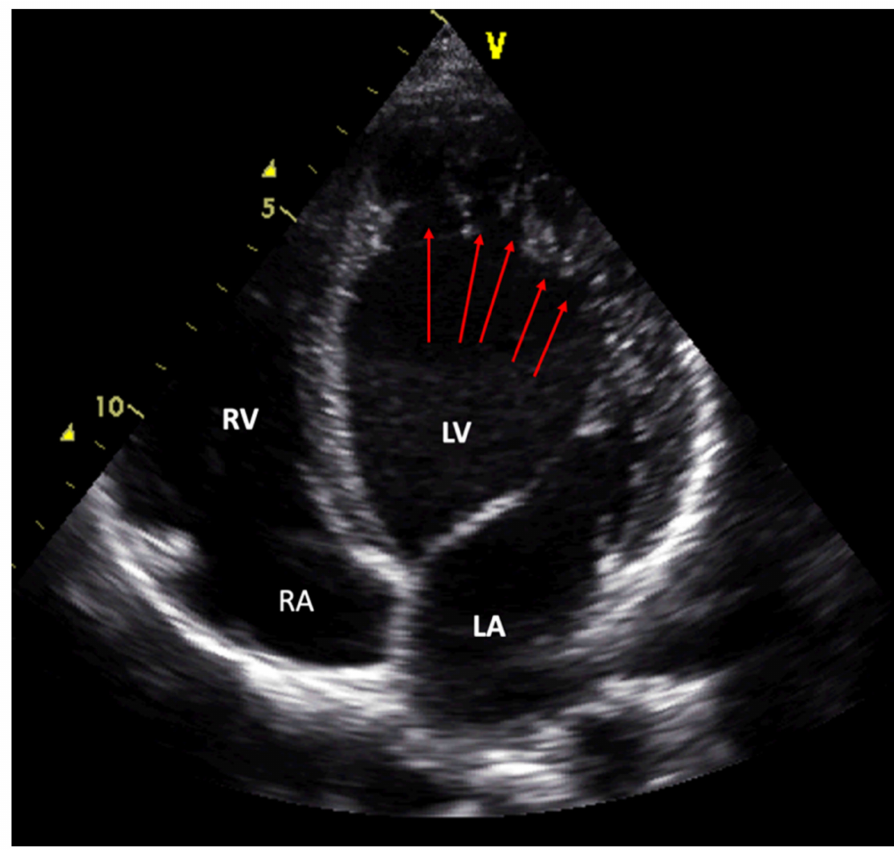
Figure 2. An echocardiographical apical 4-chamber view in a patient with NCCM. LV shows mild dilatation. The arrows mark the deep recesses in the noncompacted layer of the apical and lateral LV wall. LV—left ventricle; LA—left atrium; RV—right ventricle; RA—right atrium. LVNC can be mainly observed at the cardiac apex and in the mid-inferior, mid- anterior, and mid-lateral areas of the LV wall [67]. A low-Nyquist limit color mapping is recommended to show blood flow into the